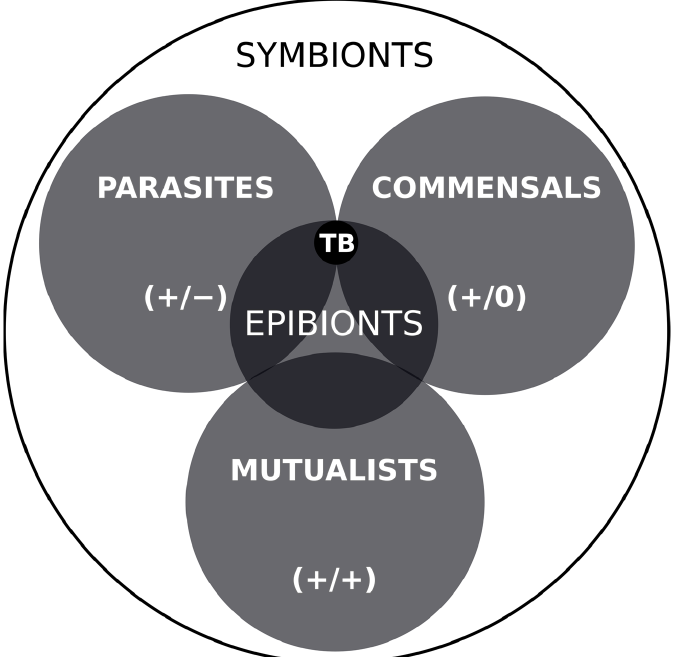
Figure 5. Venn-style diagram delineating the relationship of epibionts (i.e., organisms that live externally in association with a host partner or basibont) to different categories of symbionts. Plus, minus and zero symbols indicate beneficial, deleterious and neutral associative outcomes for the epibiont (left of the slash) and the basibiont (right of the slash), respectively. “TB” indicates the reconstructed position of turtle barnacles, which have alternatively been classified as commensals or as parasites. All the organisms together in an epibiotic association comprise a single communal entity, the holobiont, which represents a discrete ecological unit. Redrawn and modified after Pinou et al. [138]. As unique as they may appear, the few fossil holobionts that are known to date likely represent the tip of the iceberg. In fact, despite the common and widespread occurrence of carapacial and plastral remains of turtles in many fossil vertebrate assemblages world-